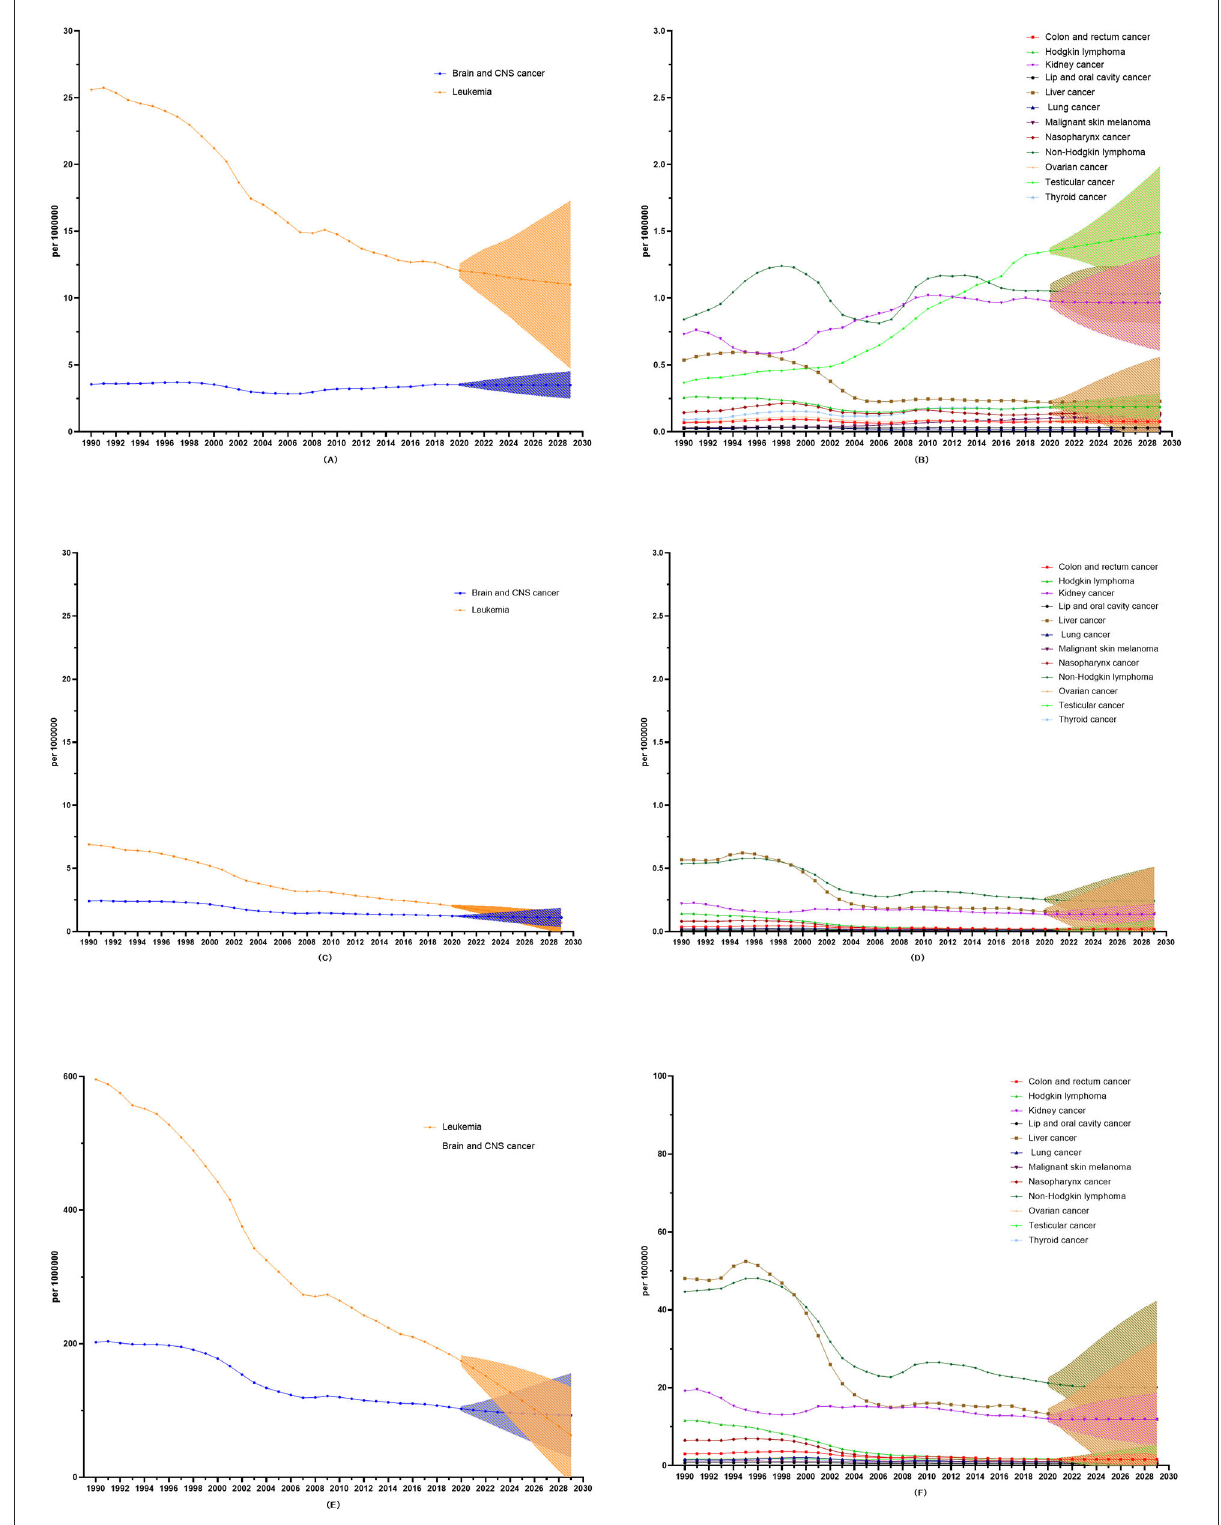
FIGURE5 10-year prediction of incidence, mortality, and DALY rates in all the childhood cancers. (A) The 10-year prediction of incidence rates in leukemia and Brain and CNS cancer. (B) The 10-year prediction of incidence rates in all the other childhood cancers. (C) The 10-year prediction of mortality rates in leukemia and Brain and CNS cancer. (D) The 10-year prediction of mortality rates in all the other childhood cancers. (E) The 10-year prediction of DALY rates in leukemia and Brain and CNS cancer. (F) The 10-year prediction of DALY rates in all the other childhood